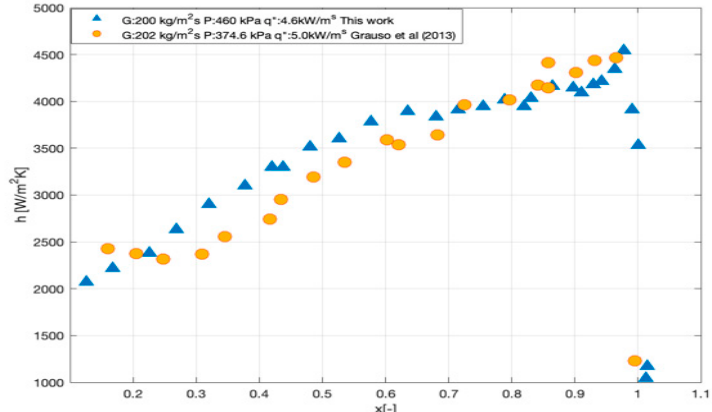
Figure 4. Comparison of two-phase heat transfer experimental results from this facility with similar cases from literature [20]